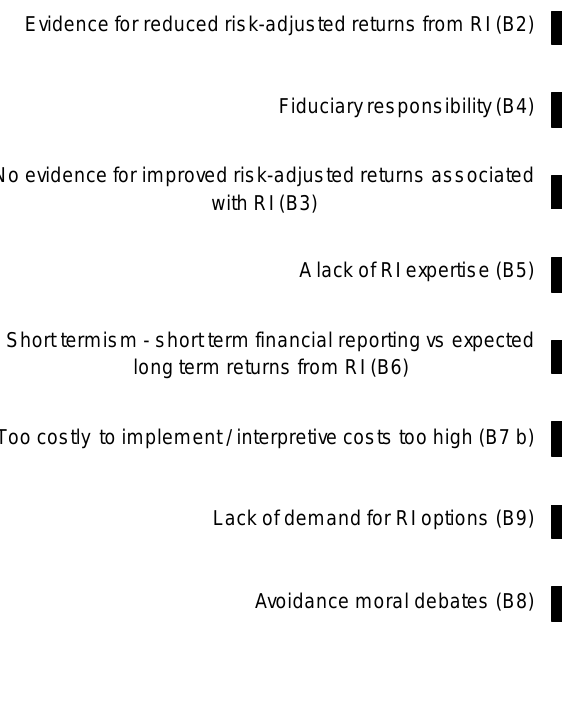
Figure 1: Pension funds - Barriers to